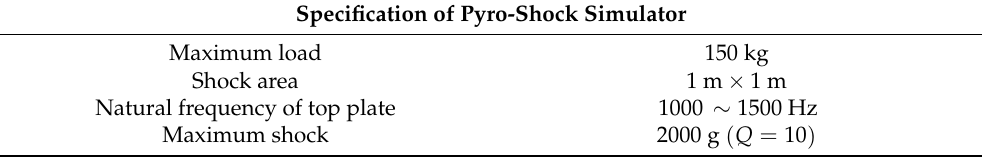
Figure 15. Typical shock isolators made of rubber, spring, etc.